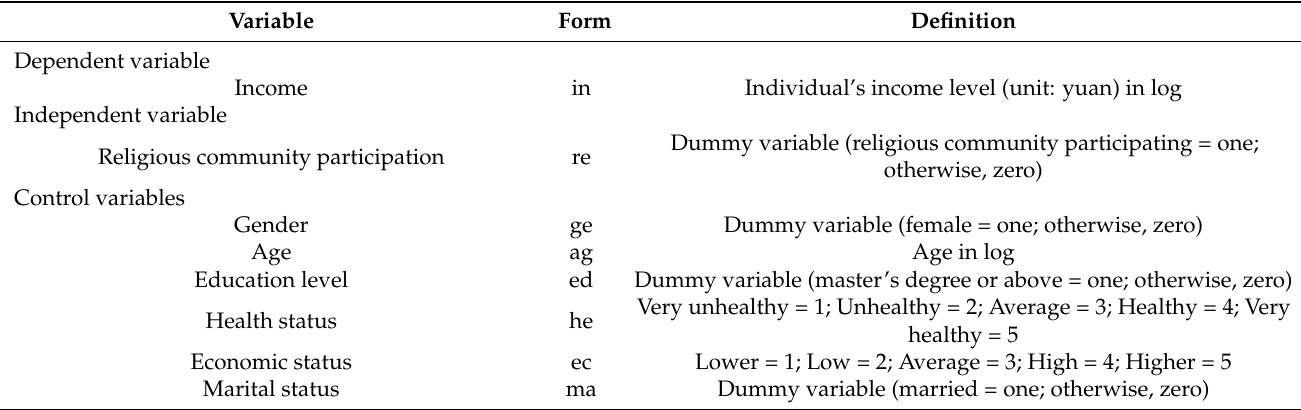
Table 1. Variable